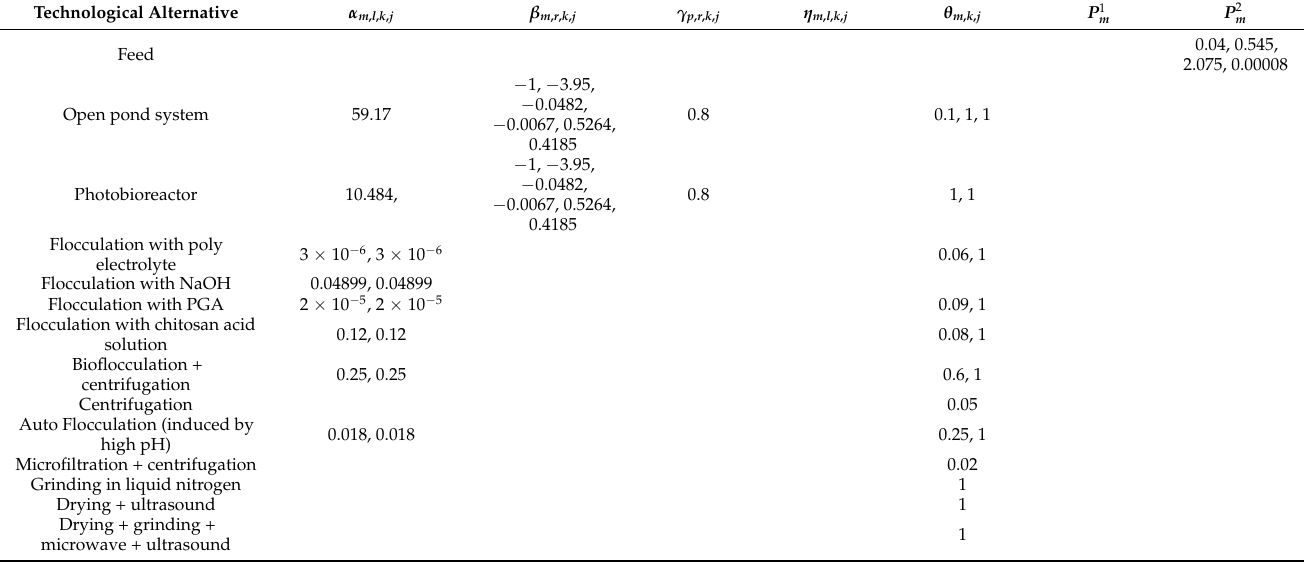
Table A1. Literature-cited data for the 46 technological alternatives considered in the case